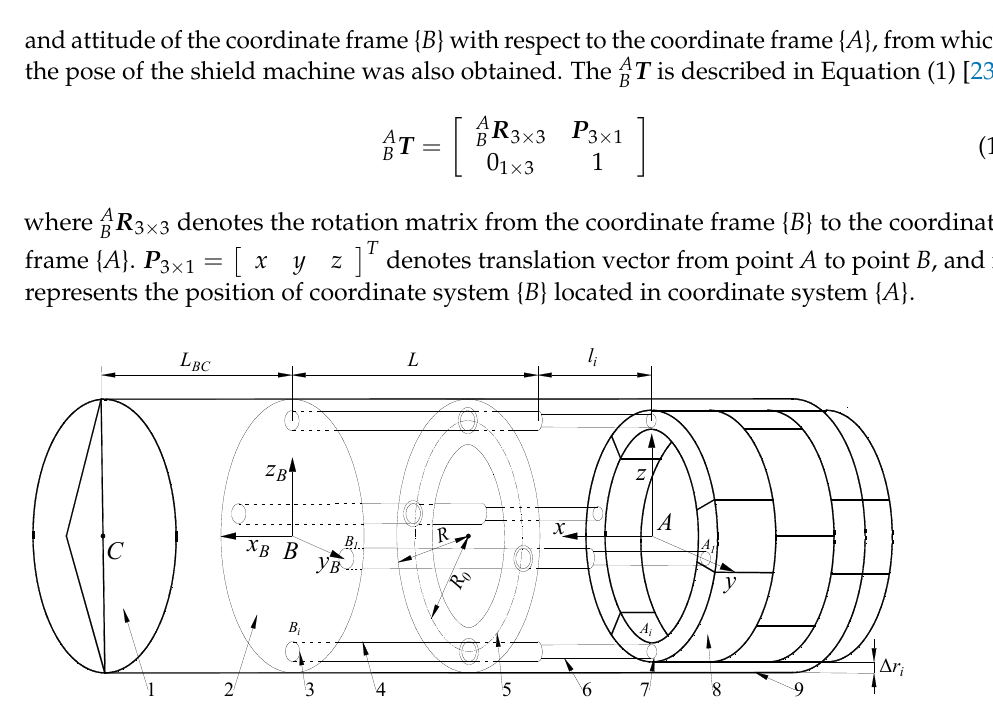
Figure 1. Schematic diagram of driving mechanism and the layout of coordinate systems [24]. 1: cutter head; 2: backplane of the middle shield; 3: front hinge of the i th cylinder; 4: cylinder sleeve; 5: flange plate attached to the shield; 6: cylinder rod; 7: rear hinge of the i th cylinder; 8: segment ring; 9: shield shell.